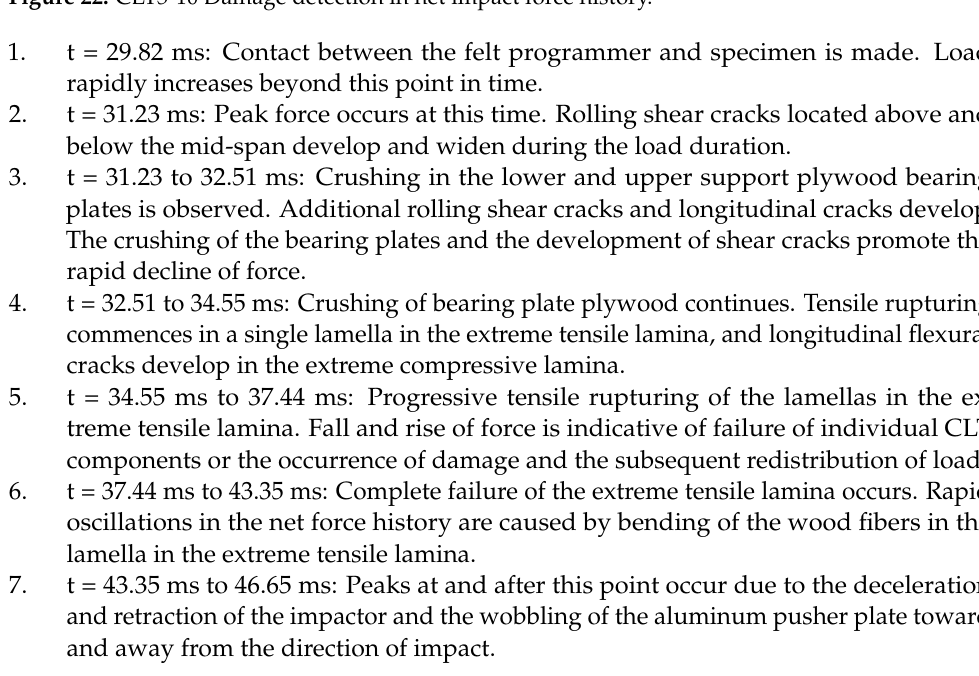
Figure 22. CLT5-10 Damage detection in net impact force